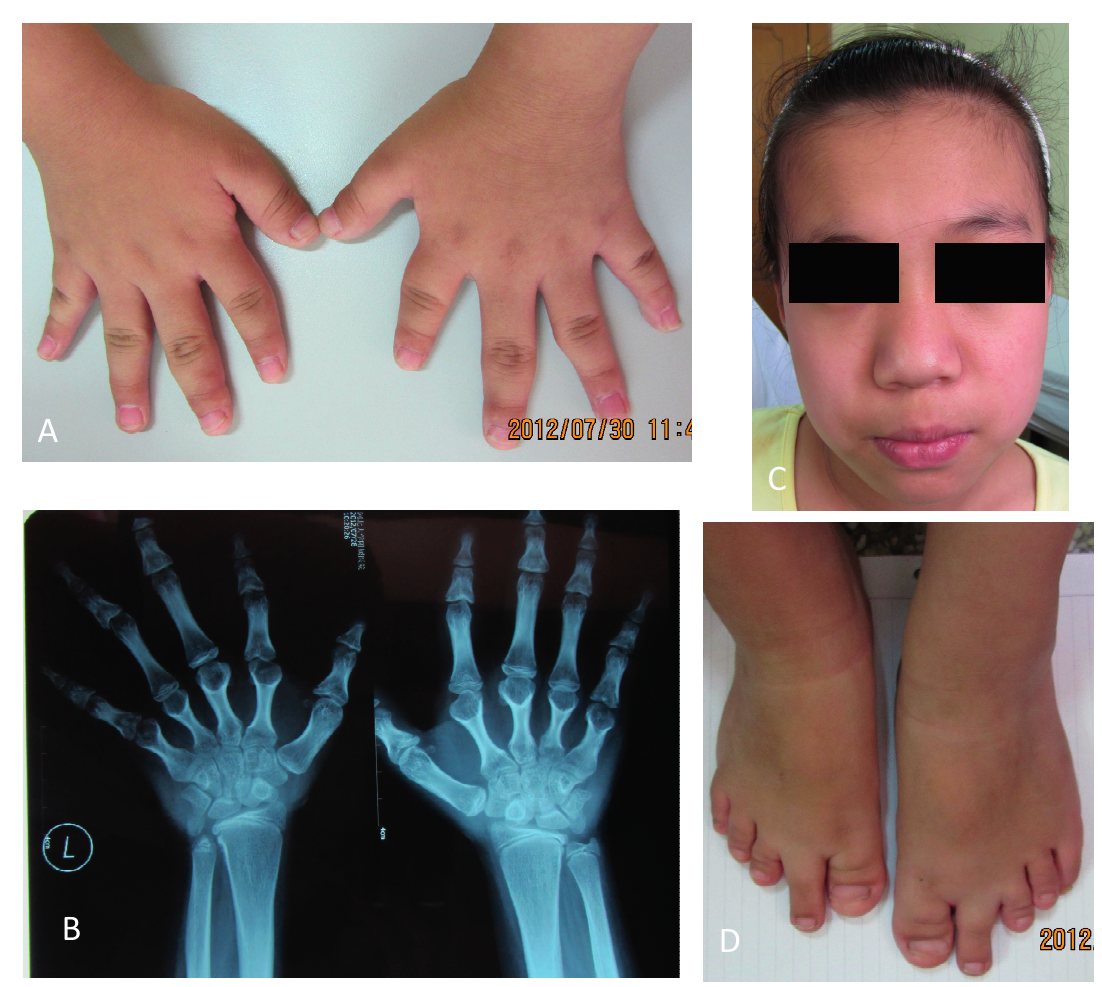
Figure 1. Patient photographs and X-ray images. ( A ) Small hands; ( B ) X-ray of the patient’s hands shows shortened metacarpals; ( C ) Round face and “pug-nose” can be observed in the patient’s photograph; and ( D ) Photograph of the patient’s feet shows shortened toes and